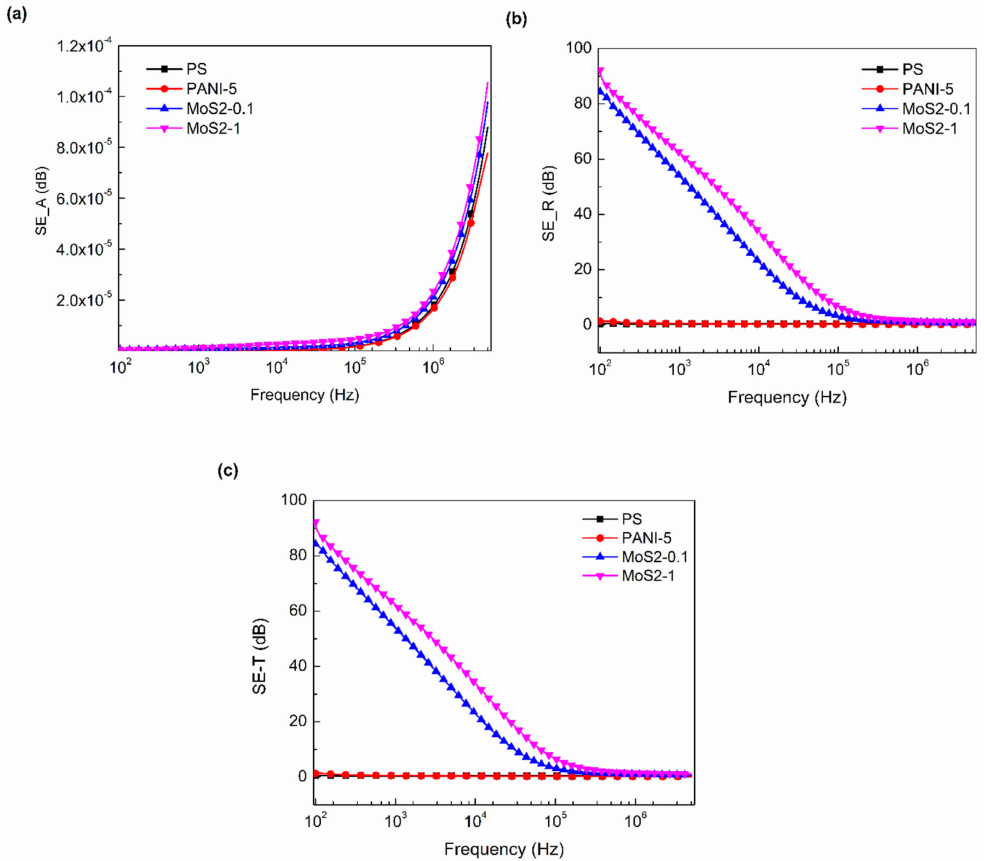
Figure 7. Electromagnetic interference (EMI) shielding behavior of PS, PANI, PS / PANI-5 wt % polymer blend, and PS / PANI / MoS 2 hybrid polymer composites at various concentrations of MoS 2 on the basis of ( a ) absorption shielding e ff ectiveness ( SE A ), ( b ) reflection shielding e ffi ciency ( SE R ), and ( c ) total shielding e ffi ciency ( SE T ), as a function of